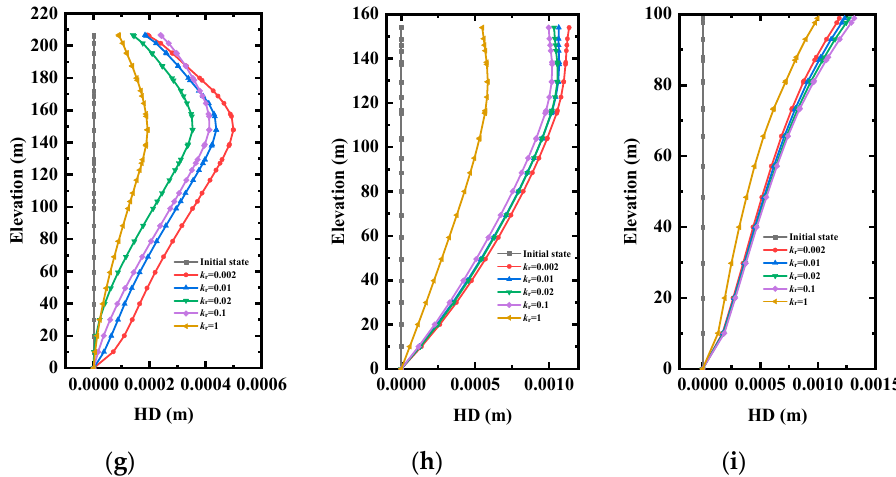
Figure 10. Horizontal displacement levels at different positions on the layered rock slope under different k r values with β = 0, β = 45, and β = 90°: ( a ) Top of the slope with β = 0°; ( b ) middle of the slope with β = 0°; ( c ) bottom of the slope with β = 0°; ( d ) top of the slope with β = 30°; ( e ) middle of the slope with β = 30°; ( f ) bottom of the slope with β = 30°; ( g ) top of the slope with β = 90°; ( h ) middle of the slope with β = 90°; ( i ) bottom of the slope with β = 90°.